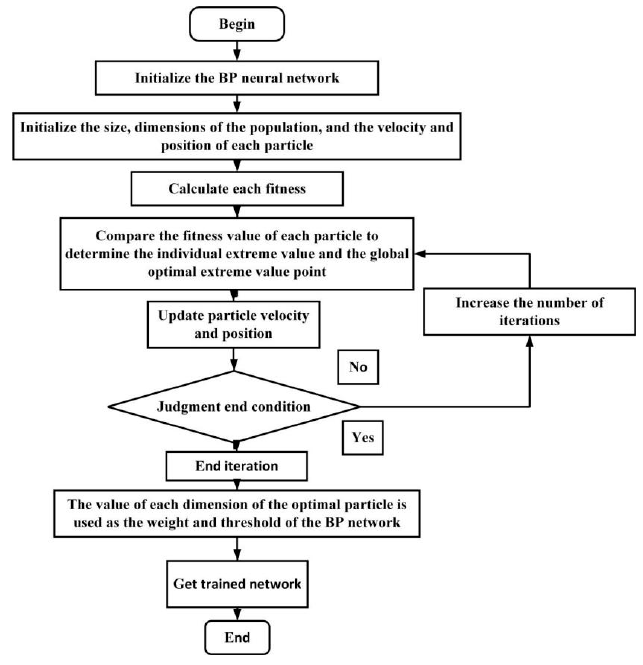
Figure 3. PSO-BP algorithm flowchart.